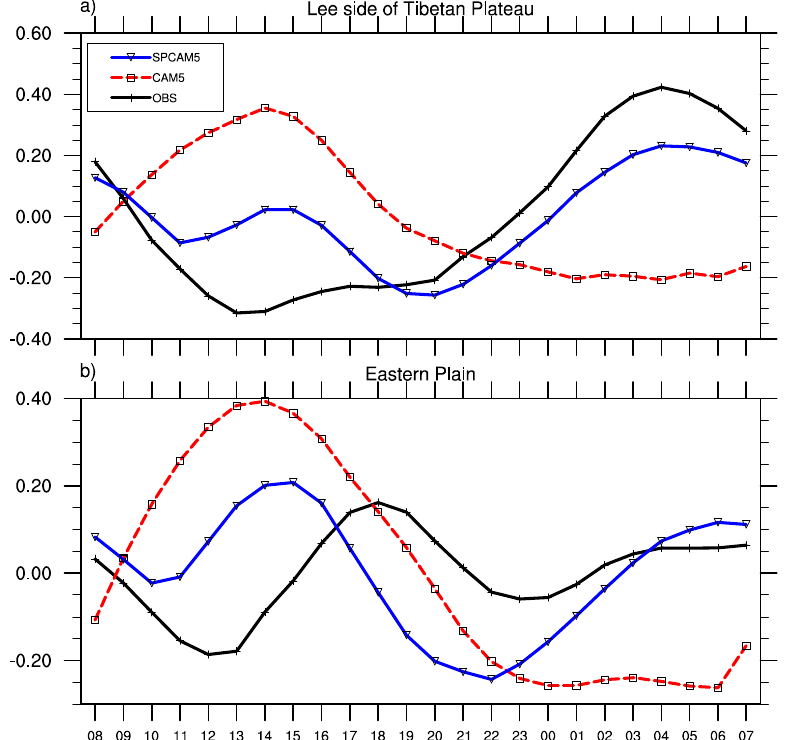
Figure 2. The diurnal cycles of normalized rainfall rates averaged within two regions, ( a ) on the lee side of the Tibetan Plateau (27–32° N, 103–108° E), and ( b ) the eastern plain of China (32–40° N, 110–118° E); the horizontal axis denotes local solar time.